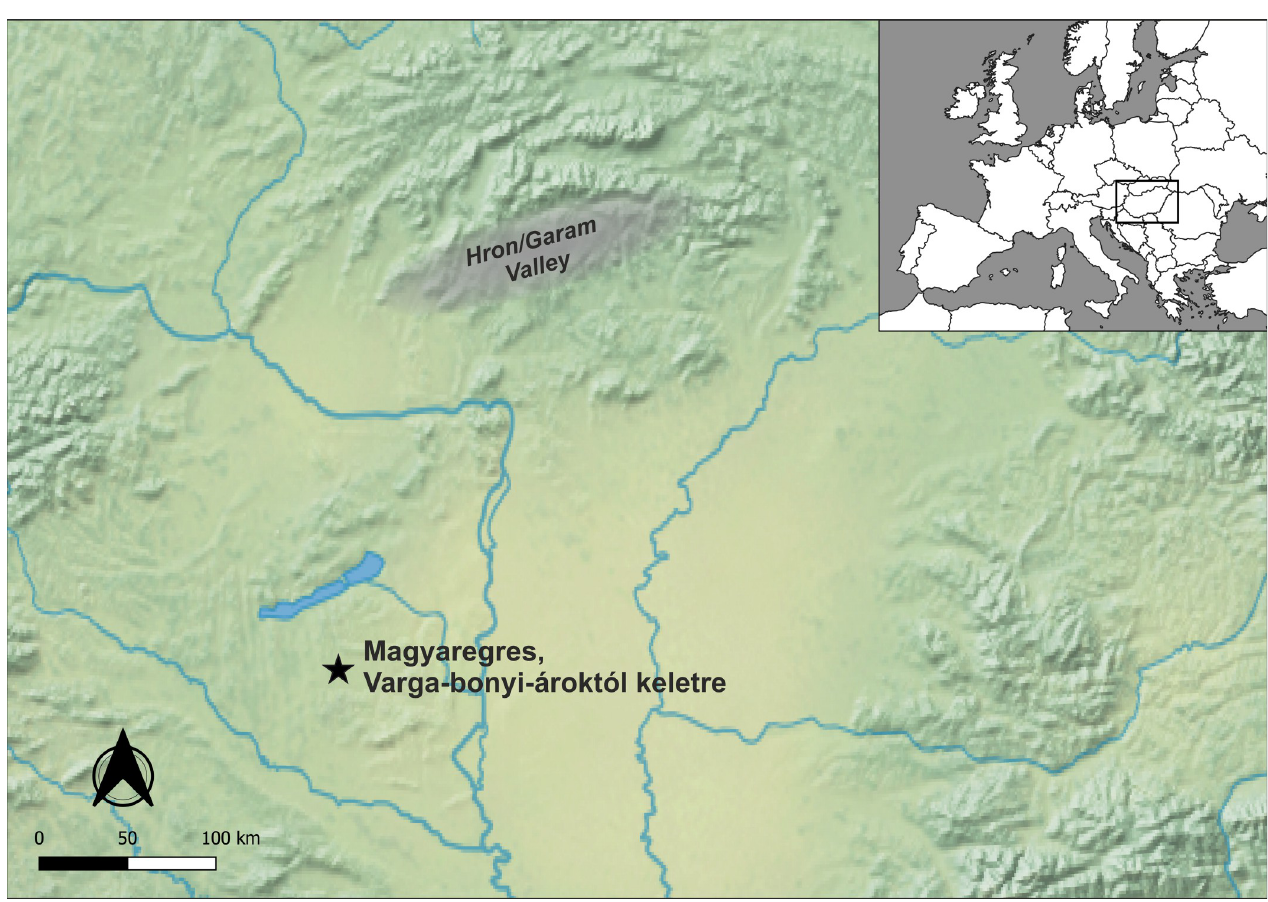
Fig 1. Map showing the location of the site and the area of supply for copper raw materials. The map is created using “Natural Earth. Free vector and raster map data” available at